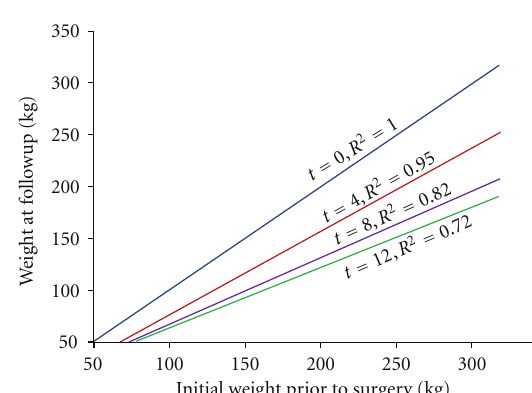
Figure 2: Linear regression of initial weight versus weight at followup. t refers to the month time interval after surgery. n refers to the number of patients in the linear regression model. t = 0, n = 1551; t = 4, n = 409; t = 8, n = 245; t = 12, n =